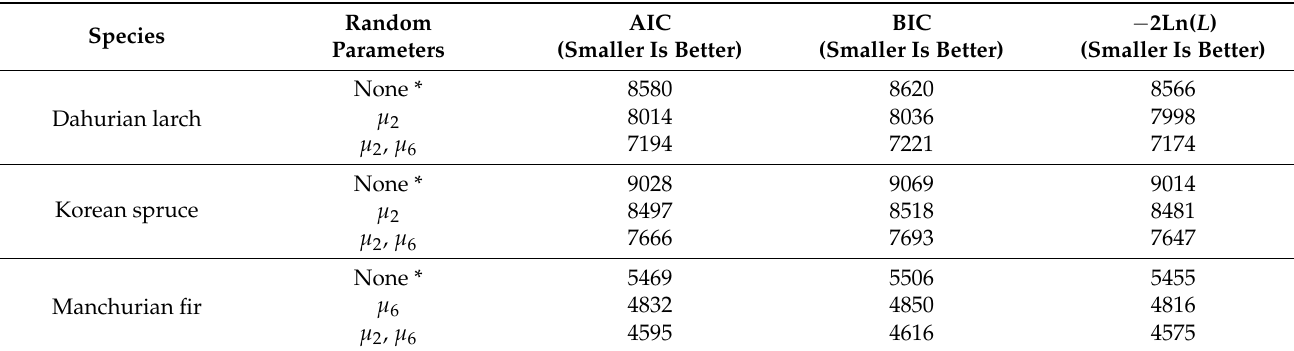
Table 2. Fit statistics for Clark (1991) Model 2 with different combinations of random parameters for three tree species.